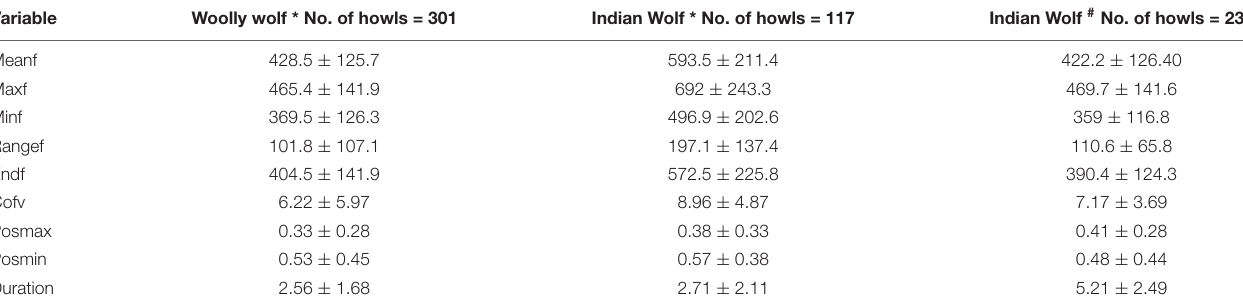
TABLE 2 | Comparison of the vocalization parameters of the Woolly and Indian wolf based on the published literature. Variable Woolly wolf * No. of howls = 301 Indian Wolf * No. of howls = 117 Indian Wolf # No. of howls =